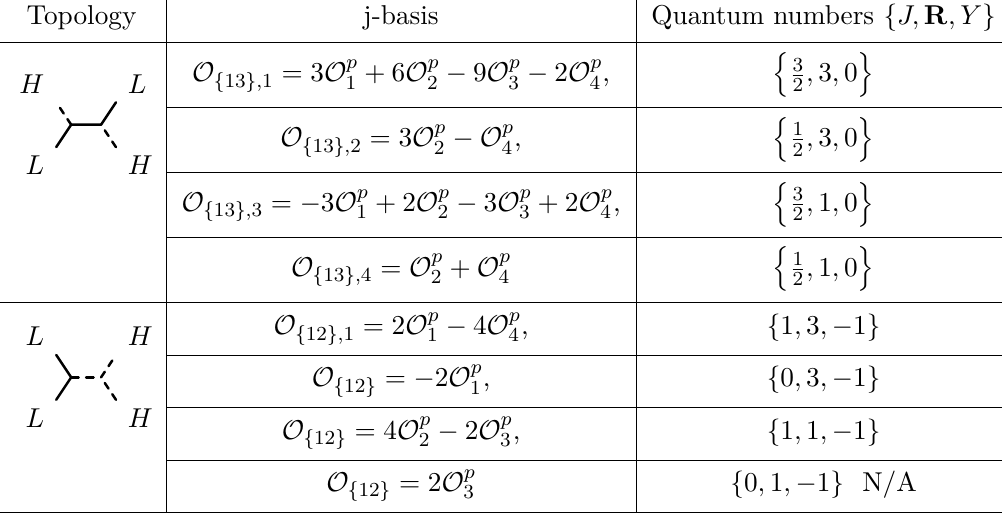
Table 12 . The complete j-basis for operator LLHHD 2 in two different topologies. Among the 7 UV resonances for this operator, three of them are the same as the seesaw model resonances, and the other four carry higher spin quantum numbers. Still the last one vanishes because of the repeated field in the operator